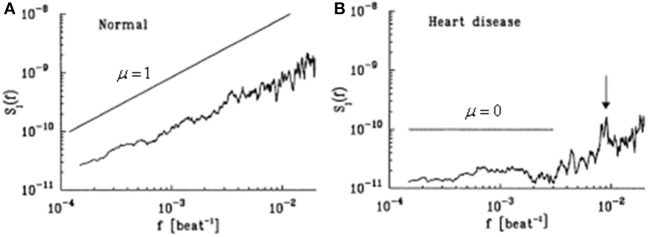
The power spectrum for the interbeat interval increments sequences over a 24 h period. (A) Data from healthy adult. The best-fit line for the low-frequency region has a slope 0.93. (B) Data from a patient with severe heart failure. The best-fit line of the low-frequency region has slope 0.14 (Adated from Peng et al., 1993 with permission).